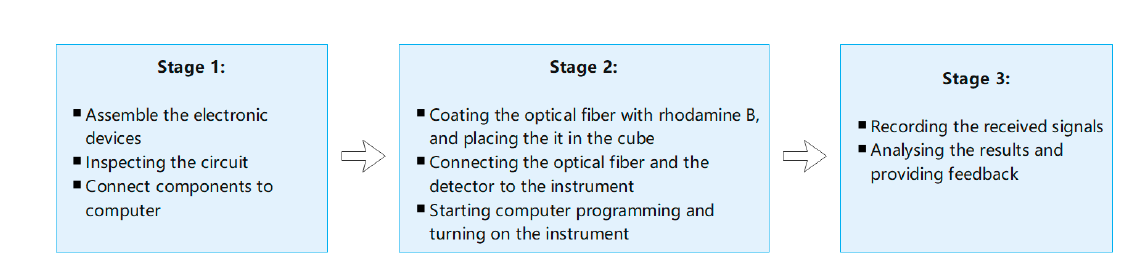
Figure 7. Illustration of the three experiment